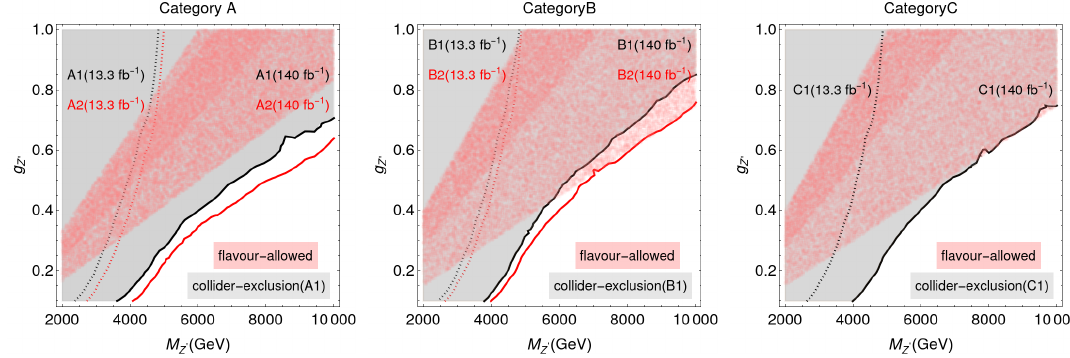
Figure 3 . The constraints in the ( M Z 0 , g Z 0 ) plane for scenarios from categories A, B and C, with V dL = V CKM . While the light pink bands represent the combined 2 σ -allowed parameter space from the meson mixing data [68] and b → s global-fit [69] in 2016, the darker bands include the 2018 constraints from the meson mixing data [30] and the 2021 updates to the b → s global fits [21]. The regions above the dotted (solid) lines are excluded at 95% C.L., with 13.3 (140) fb − 1 total integrated luminosity, using dimuon searches [31, 33]. The gray bands indicate the current exclusion for scenarios A1, B1 and